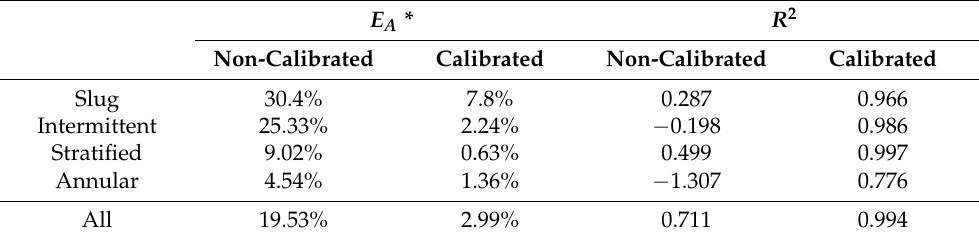
Table 4. Discrepancy between the QCV technique and the capacitance method with the proposed calibration technique. E A * R 2 Non-Calibrated Calibrated Non-Calibrated Calibrated Slug 30.4% 7.8% 0.287 0.966 Intermittent 25.33% 2.24% − 0.198